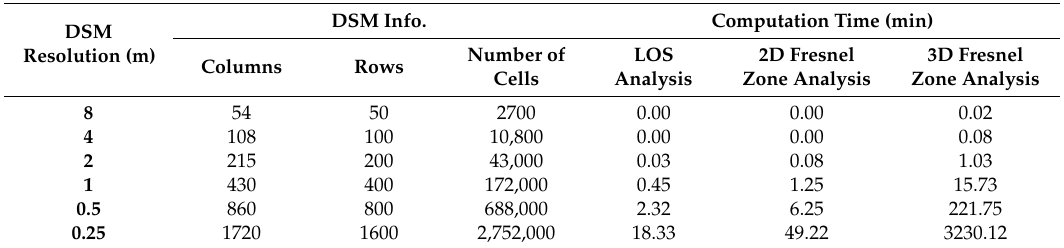
Table 3. Comparison of the computation time for each method at different DSM resolutions.